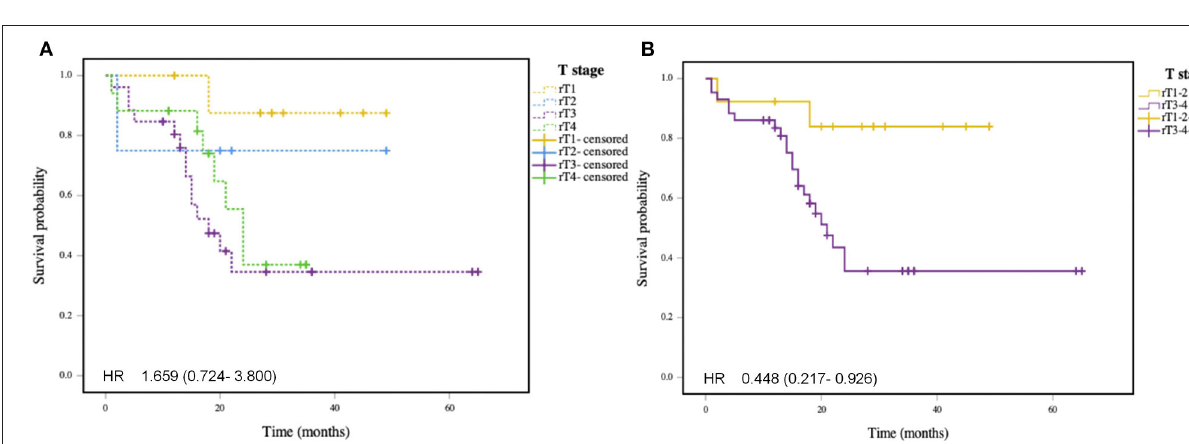
FIGURE 1 | Kaplan-Meier curve of overall survival in patients with recurrent NPC.